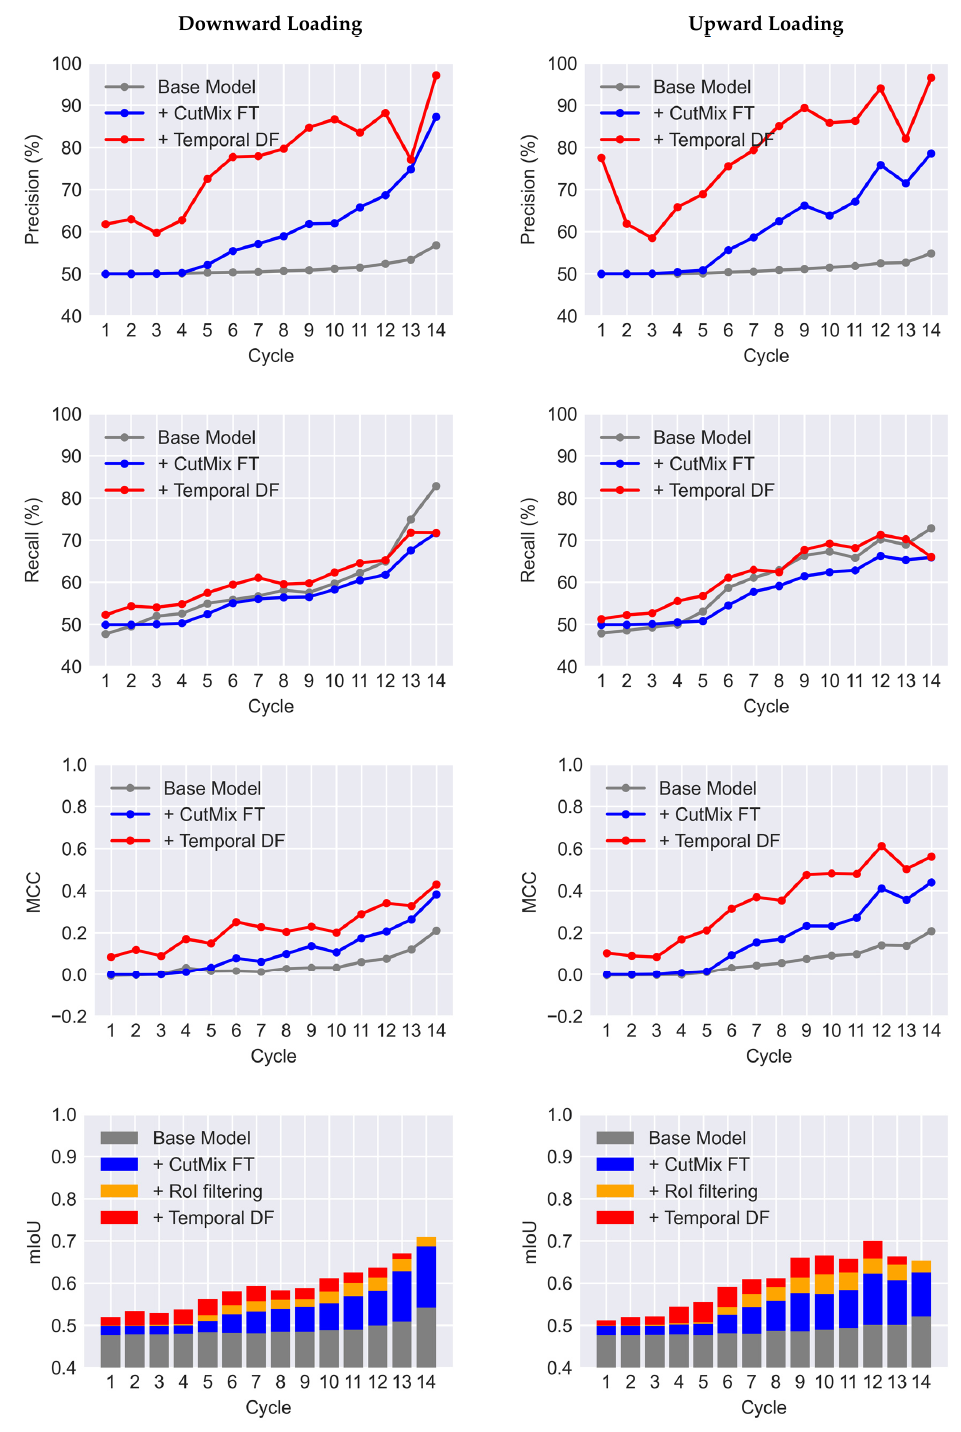
Figure 10. Breakdown of accuracy metrics for images of different cycles (FT: fine-tuning, DF: data fusion).